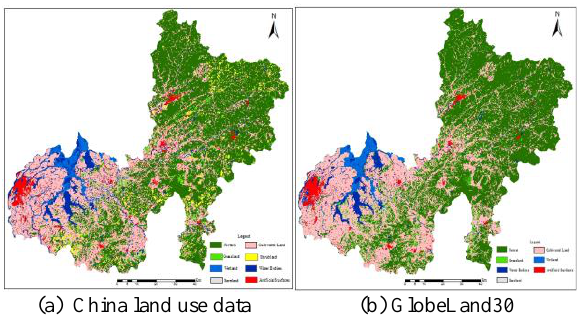
Figure 2. Land cover reclassification images in southern Jiangxi